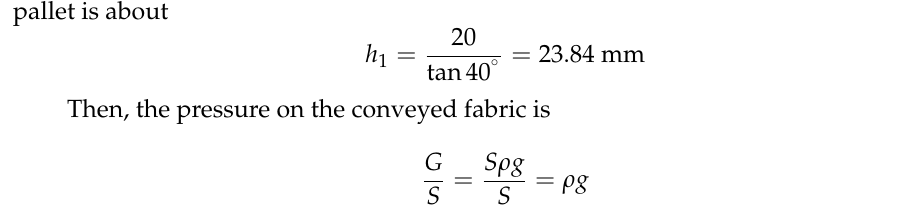
Figure 1. Force analysis of the pipeline outlet and transported logistics: ( a ) pipeline outlet diagram; ( b ) force diagram of the conveyed logistics.